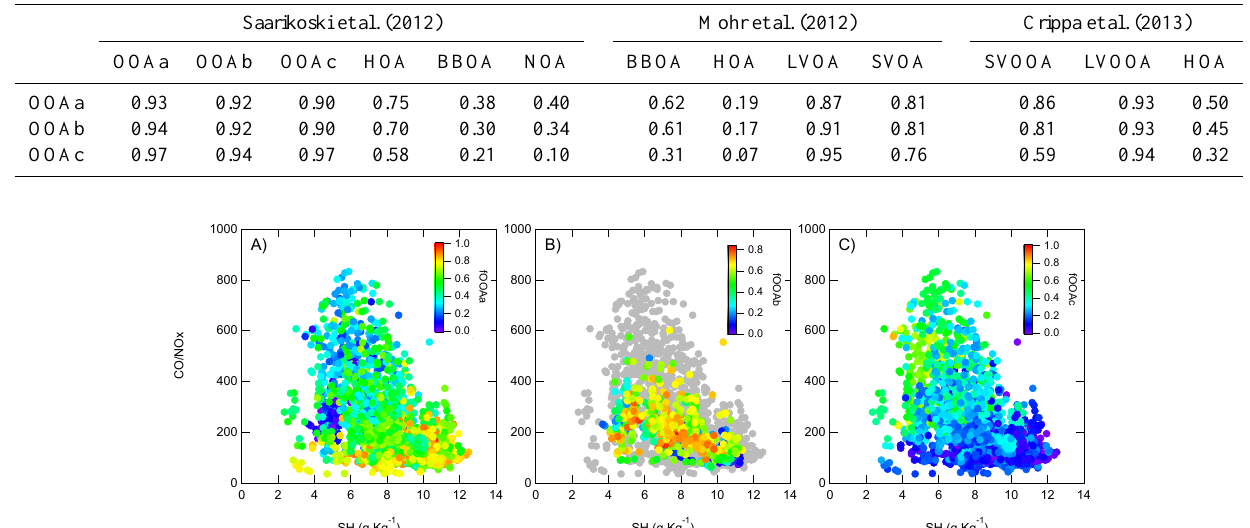
f 44 (contribution of organic mass fragments with m/z